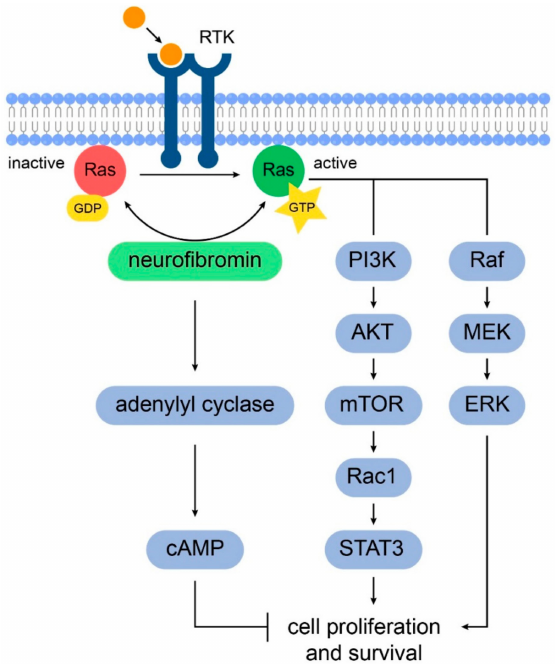
Figure 1. Schematic representation of the signaling pathways involved in NF1 tumorigenesis. Neurofibromin positively regulates adenylyl cyclase to increase intracellular cAMP levels which inhibits glial cell proliferation and survival. Also, neurofibromin promotes the conversion of active GTP-bound RAS to its inactive GDP-bound conformation. In NF1, the increased RAS activity in astrocytes leads to cell proliferation through the downstream activation of the PI3K / AKT / mTOR and RAF-MAK / MEK